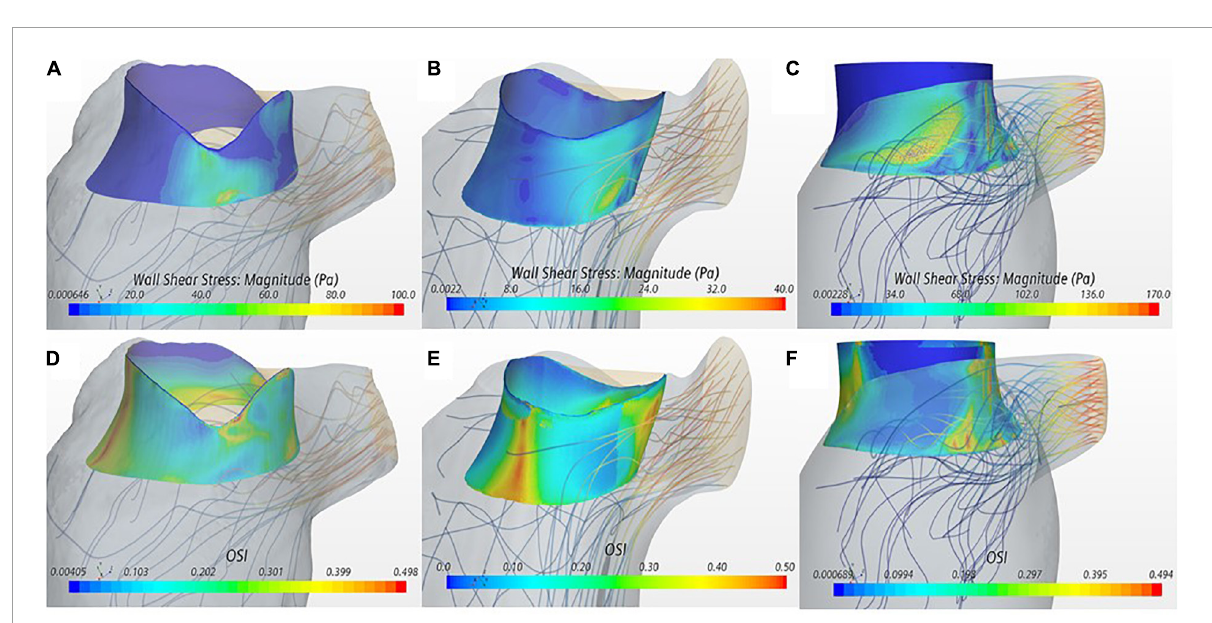
FIGURE3 (A–C) Wall shear stress (WSS) displayed on the device frame for cases VIM-1:3 (left to right). (D–F) OSI displayed on the device frame for cases VIM-1:3 (left to right). Streamlines from the aortic valve with a backward integration are included in each, velocity of the streamline is represented from low (blue) to high